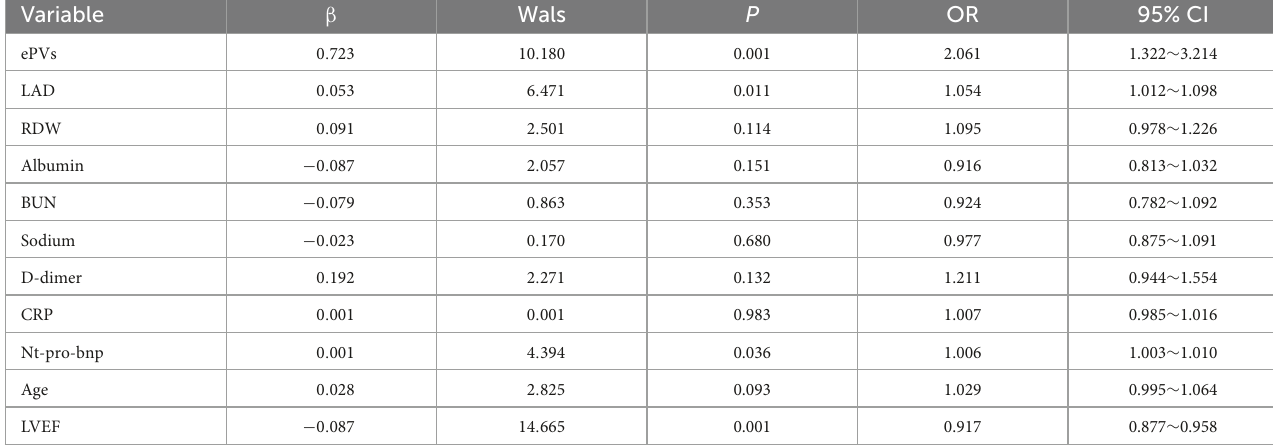
TABLE 4 Logistic regression analysis for major cardiovascular events